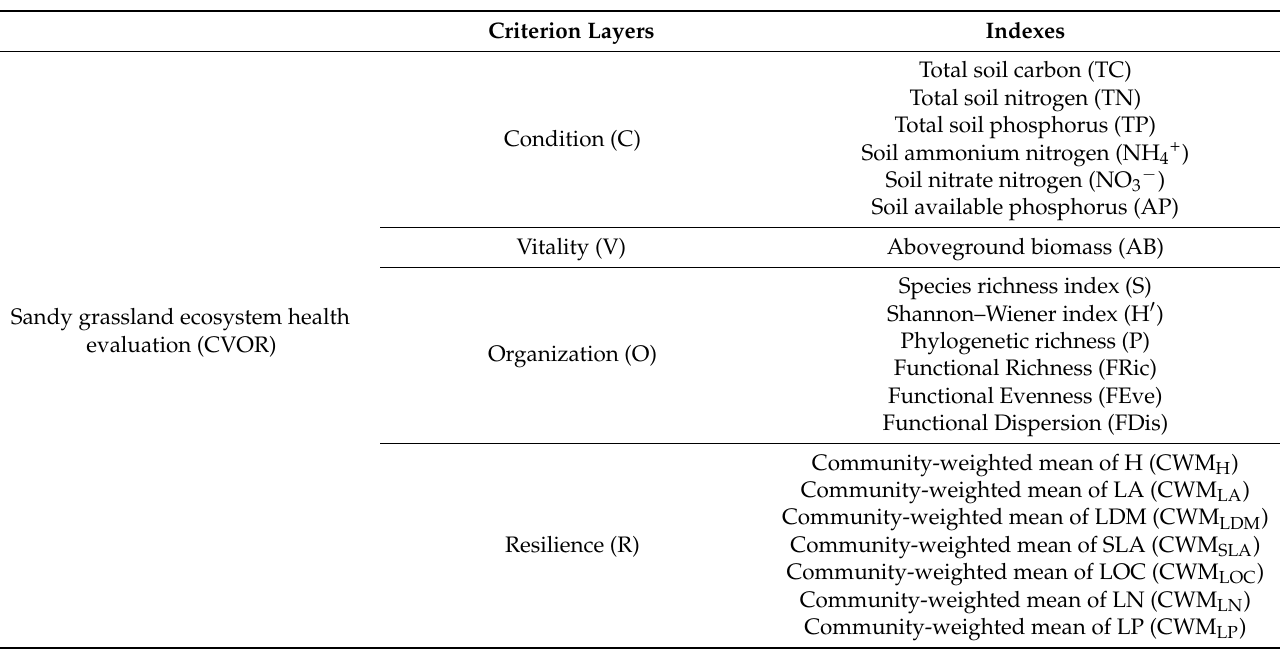
Table 1. The indices of each criterion layer in the CVOR model. Criterion Layers